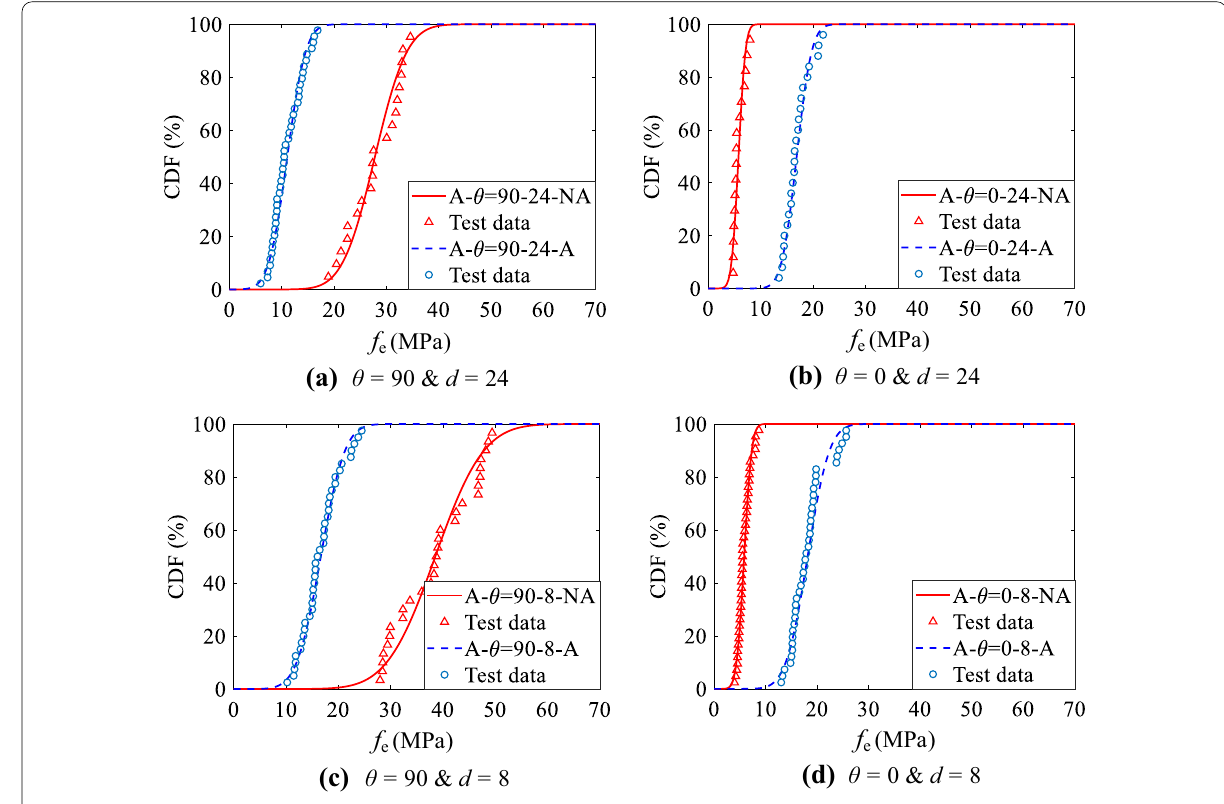
Fig. 14 Embedment strength of dowels positioned within CLT core layer and between CLT